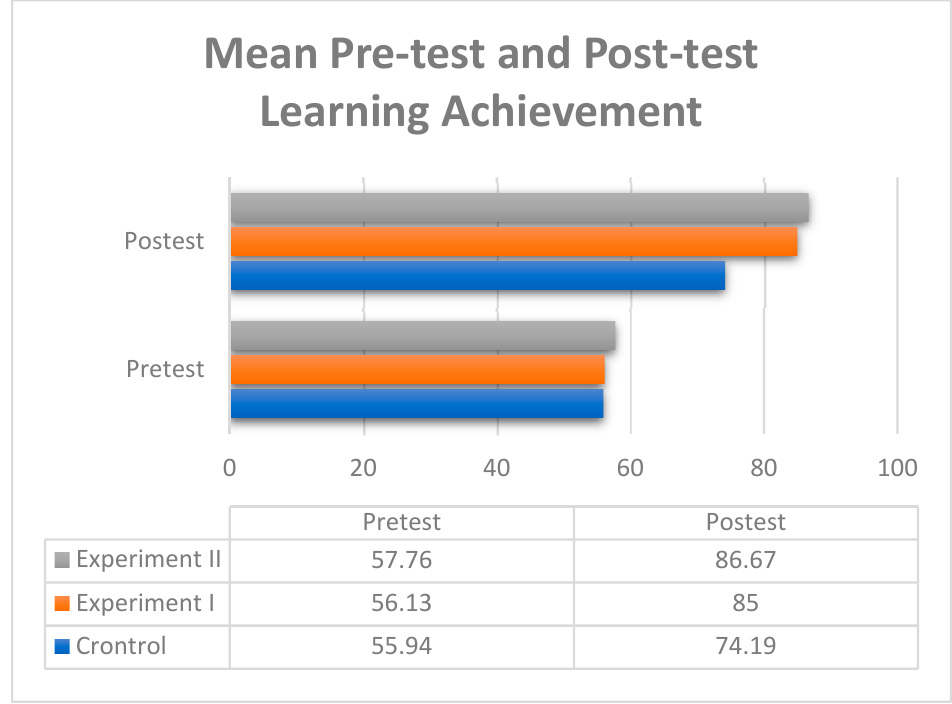
Figure 6. Mean pre-test and post-test student achievement score line graph. Table 4. ANCOVA learning satisfaction for the three classes.